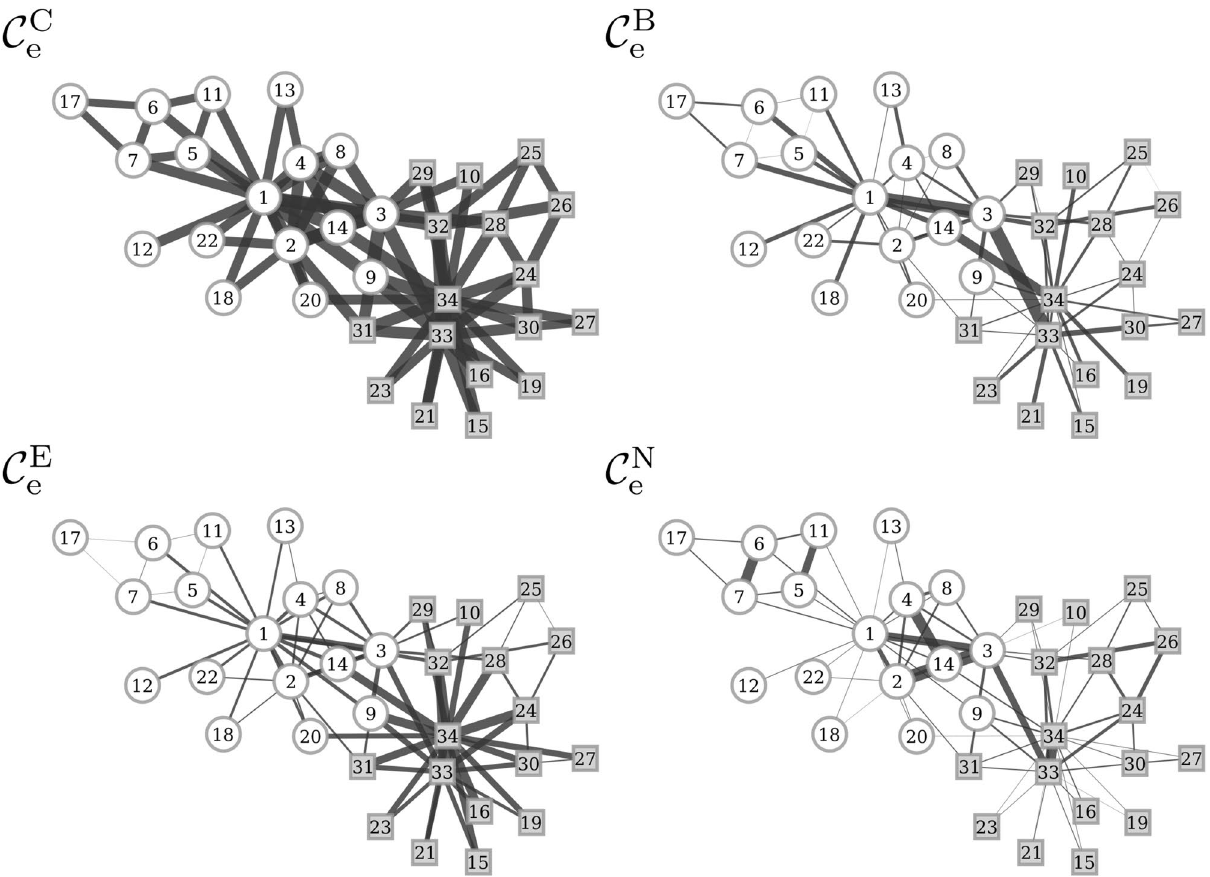
Figure 2. Key interactions in Zachary’s karate club network. Interactions identified with different edge centrality concepts (edge closeness centrality C C e ; edge eigenvector centrality C E e ; edge betweenness centrality C B C N e ; nearest-neighbor edge centrality e ). Edge importance is encoded as line thickness and numbered vertices represent the members of the club. The two factions into which the club split during the course of the study are indicated by circles [the club instructor’s group (vertex 1)] and squares [the club administrator’s group (vertex